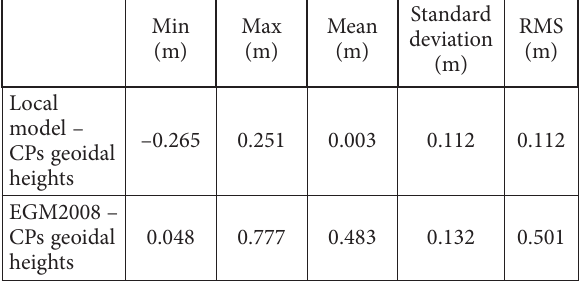
Table 6. Statistics of the differences between EGM2008 bias-corrected and CPs geoidal heights Standard